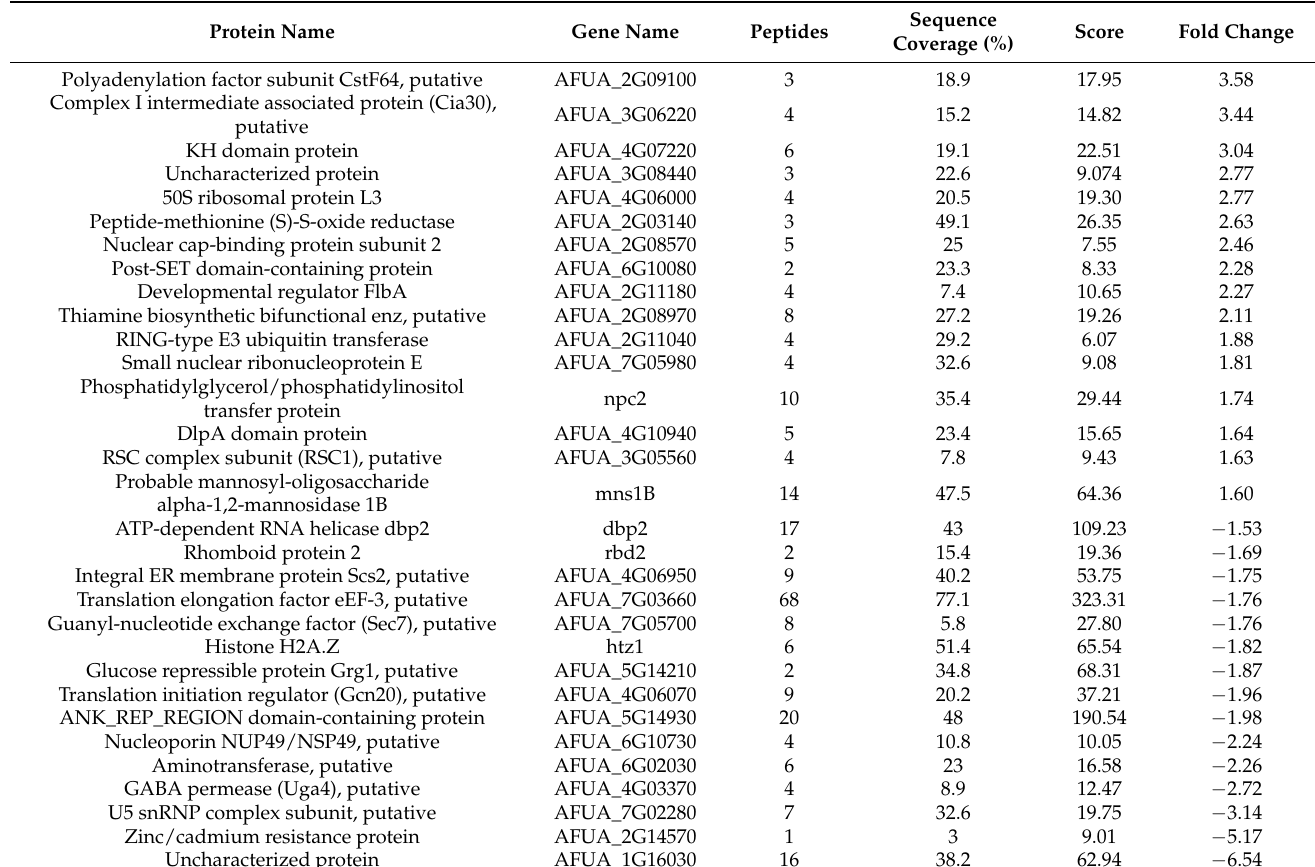
Table 1. All proteins detected to be statistically significant and differentially abundant in passaged strain E25 relative to the control A. fumigatus